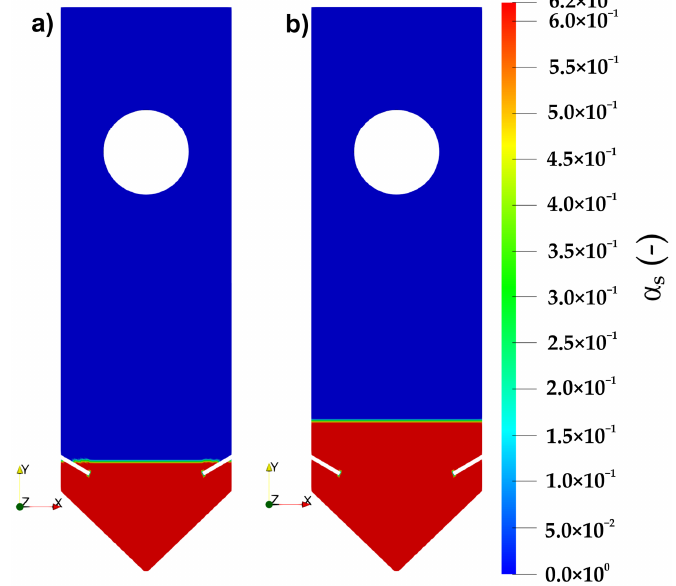
Figure 3. Initial particle loading conditions in the Euler–Euler simulations: ( a ) solid holdup of 400 g, equivalent to an initial bed height of 0.064 m; ( b ) solid holdup of 700 g, equivalent to an initial bed height of 0.088